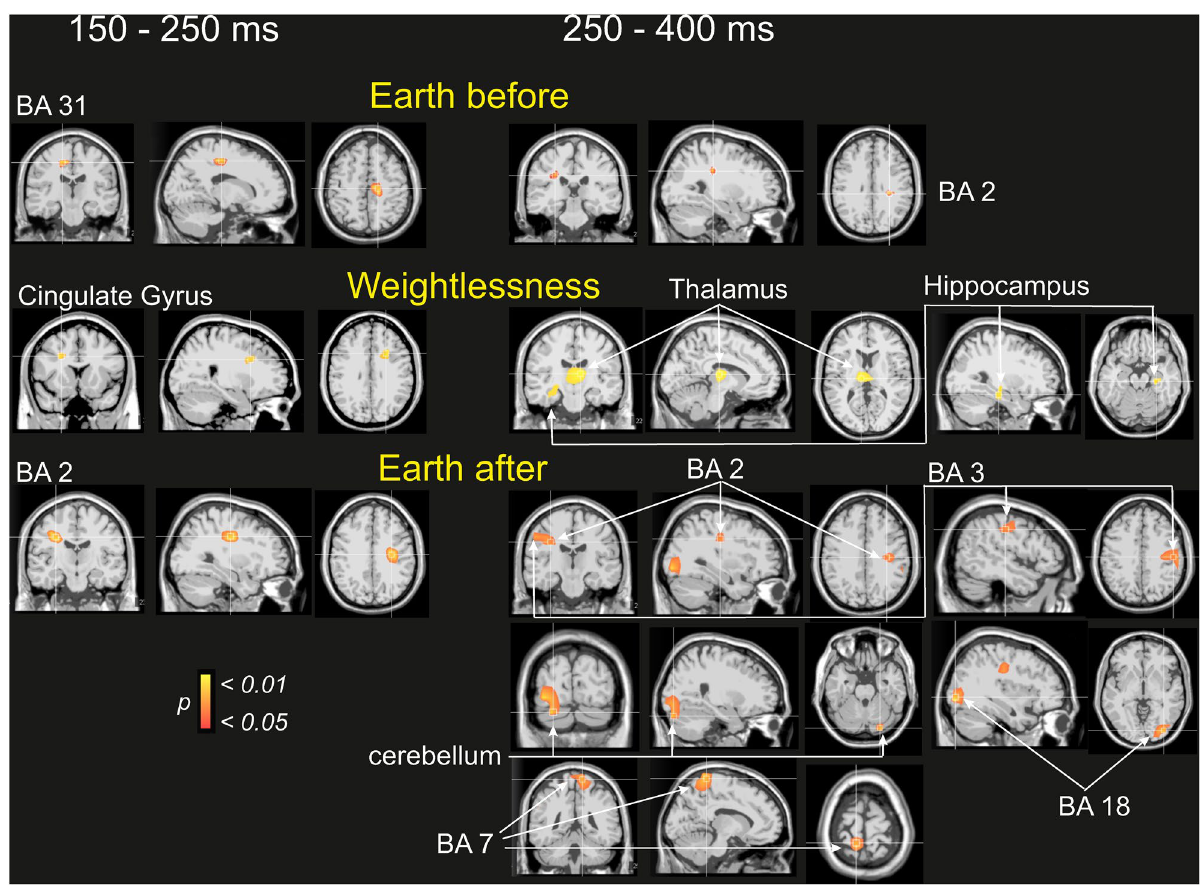
Figure 5. Sources estimations of the GOOD versus BAD (GOOD > BAD) contrasts on the Earthbefore (upper part), Weightlessness (middle part) and Earthafter (lower part) conditions. Nonparametric statistical maps calculated for the five astronauts during the two periods of interest (150–250 ms, on the left; 250–400 ms, on the